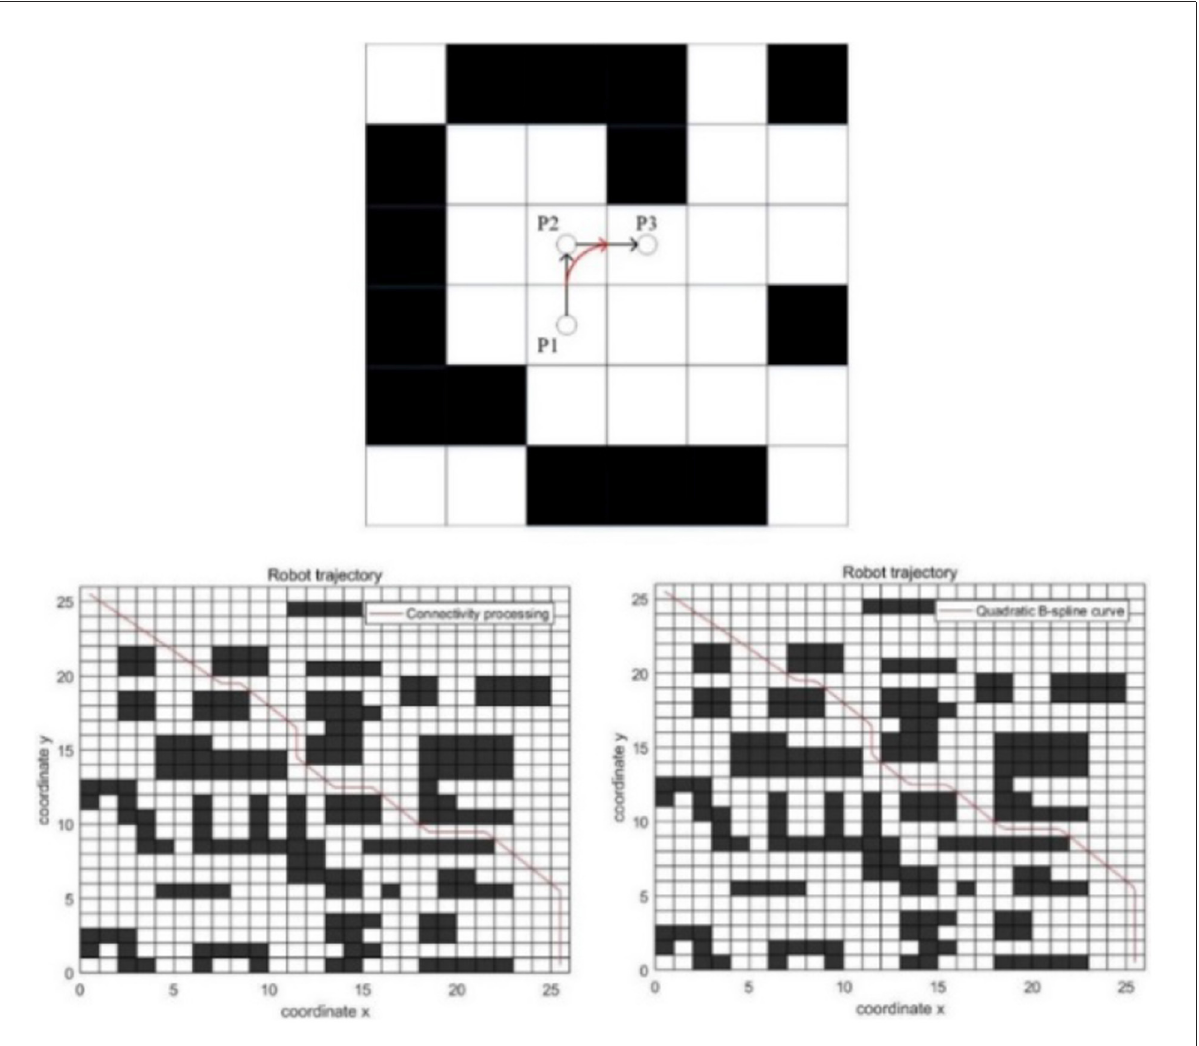
FIGURE8 Quadratic B-spline